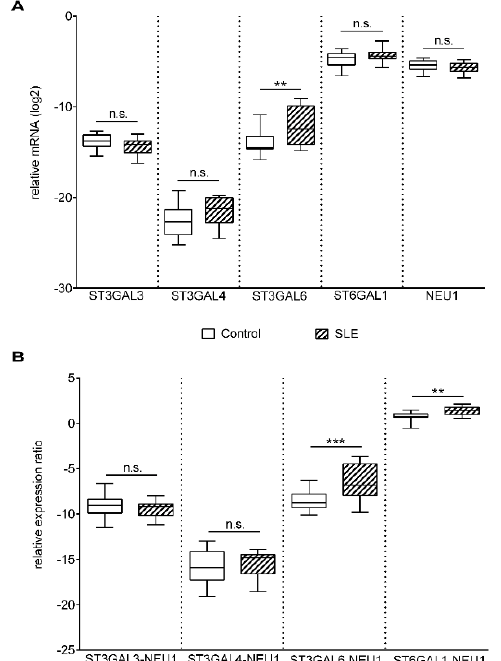
Figure 3. Gene expression of sialyltransferases (ST) and neuraminidase-1 ( NEU1 ) in activated T cells. Total RNA was extracted from activated T cells and mRNA expression levels were analyzed by qPCR.